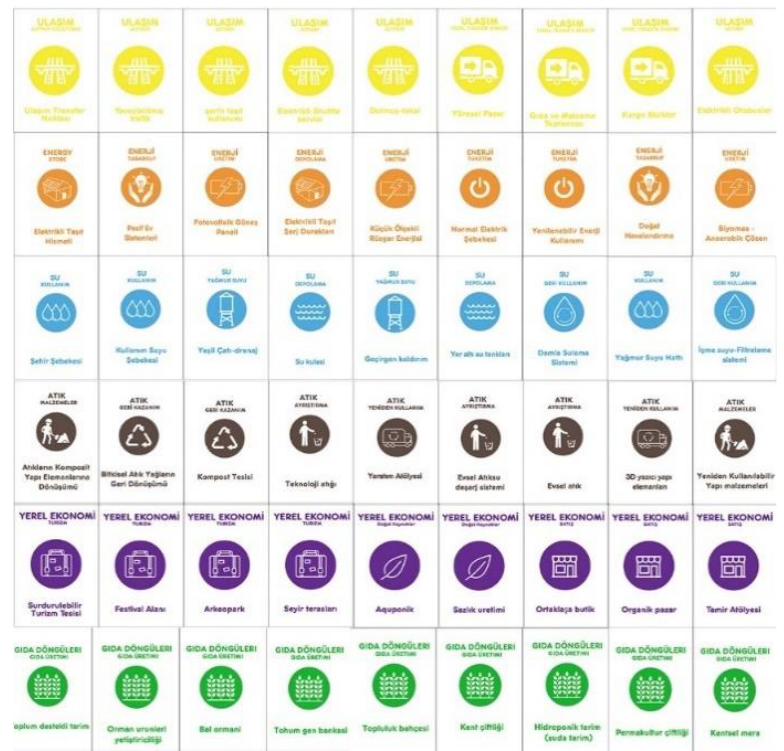
Figure 8 Strategy cards representing circular principles of mobility, water, energy food, waste and local